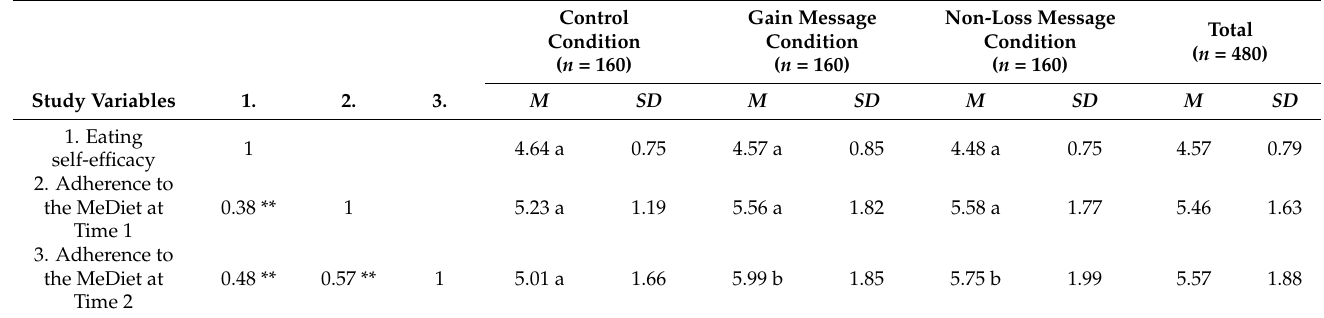
Table 2. Means, standard deviations, and correlations among measured variables in each message